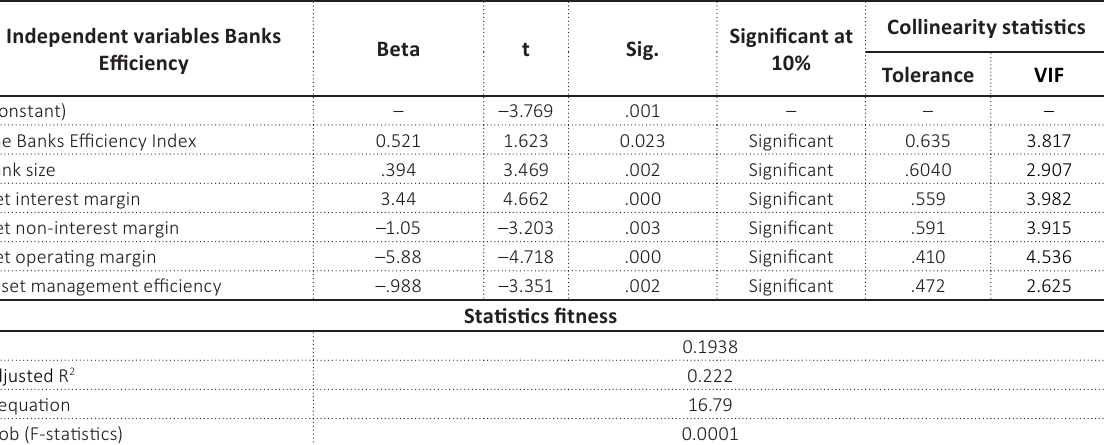
Table 11. Analysis output for Model